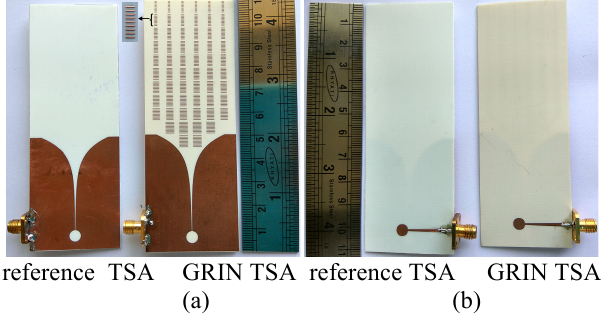
Figure 8: Photographs of the reference TSA and GRIN lens TSA (a) top view and (b) bottom view.